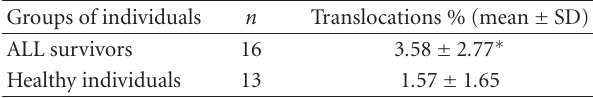
Table 2: Translocation frequency for chromosome 12 obtained for controls and childhood ALL survivors. Peripheral blood lympho- cyte samples were collected from the patients at variable periods after therapy